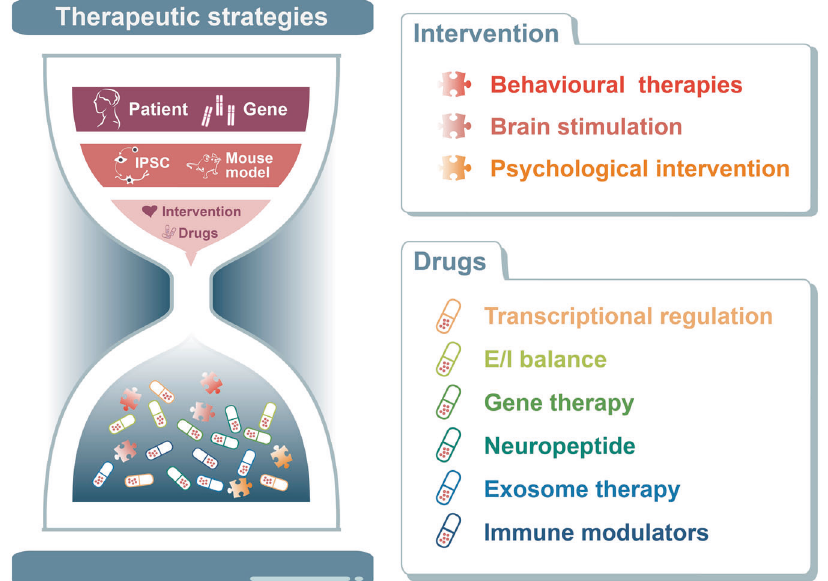
Fig. 8 Potential novel therapeutic strategies and target of ASD. Abundant basic research on mouse and iPSC models exploited potential treatments to be used in ASD patients.It is noteworthy that emerging treatments including brain stimulation, gene therapy and exosome modulators are also been